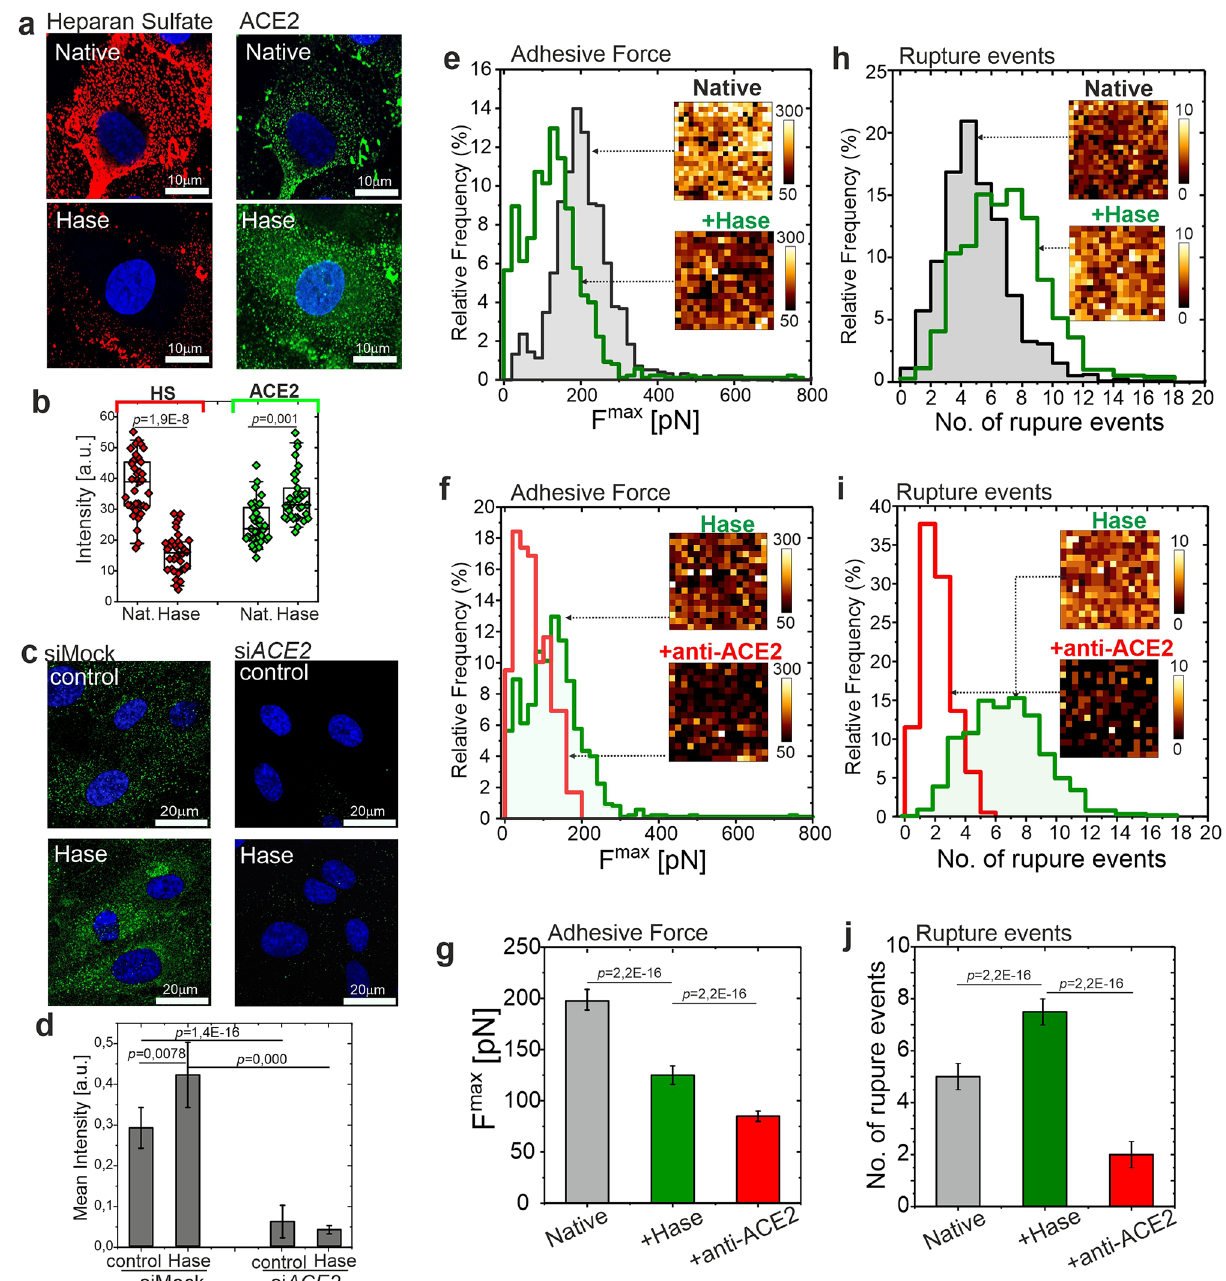
Figure 4. Removal of heparan sulfate from glycocalyx reduces the overall adhesion of S-protein to HPAECs but exposes ACE2 receptors for binding. ( a ) Fluorescence staining of HS (red, left column) and ACE2 receptors (green, right column) performed for native (top row) and heparinase (Hase) treated HPAECs (bottom row). ( b ) Quantitative data of HS and ACE2 mean fluorescence intensity. ( c , d ) Fluorescent staining of ACE2 in siMock and si ACE2 -transfected HPAECs treated with heparinase. Representative pictures and quantitative data. ( e , h ) Histograms of adhesive parameters for native cells (grey) and heparinase treated cells (green). ( f , i ) Histograms of adhesive parameters for heparinase treated cells (green) and heparinase treated cells successively incubated with anti-ACE2. ( g , j ) Comparison of mean values. Left: plots for maximal detachment force. Right: plots for the number of rupture events. In all histograms and insets show selected spatially resolved maps (25 µm × 25 µm). Statistics: p values were determined by one-way ANOVA followed by Tukey’s post-hoc test. Experimental details are listed in Supplementary Table 1. Source data are provided as a Source Data file. HS heparan sulfate, Hase heparinase, anti-ACE2 ACE2 blocking antibody, Glx glycocalyx. Figure created with OriginPro2021 (https:// www. origi nlab. com/ 2021), ImageJ 1.53e (https:// imagej. nih. gov/ ij/) and JPK Data Processing 6.1.79 (https:// www. jpk.